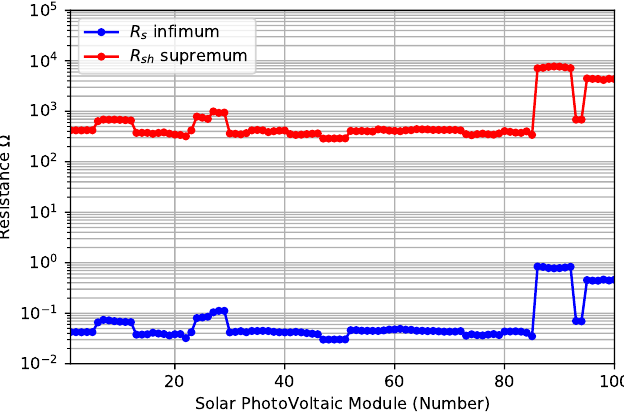
Figure 16. Behavior of R s , inf and R sh , sup for the different SPVM included in the database.